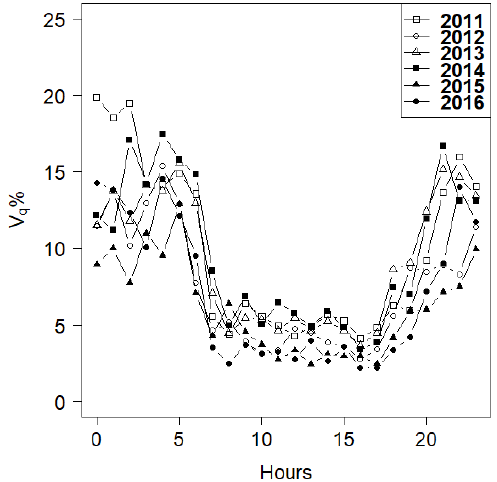
Figure 6: Relation between the coeflcient Vq of annual hourly traflc flow and time at business day in 2011–2016 for all vehicle sets